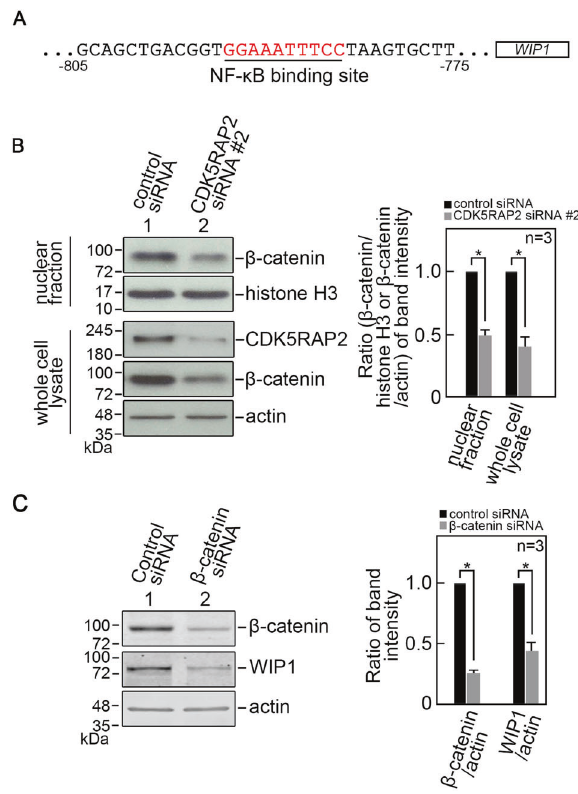
Fig. 5 CDK5RAP2 loss reduces β -catenin level. A The WIP1 promoter contains an NF- κ B binding site [32]. BJ cells transfected with CDK5RAP2 siRNA #2 ( B ), or β -catenin siRNA ( C ) for 3 days were analyzed by SDS-PAGE and immunoblotting. Nuclear fractions and whole-cell lysates in ( B ) were probed for β -catenin and histone H3 (nuclear fraction) or CDK5RAP2 and actin (whole cell lysate), and whole cell lysates in ( C ) were probed for β -catenin, WIP1, and actin. Actin blot was used as a loading control. Representative blots are from one of three independent experiments ( n = 3) showing similar results. Ratios of levels of β -catenin vs histone H3 (in nuclear fraction) or actin (in whole cell lysate) in ( B ) and β -catenin or WIP1 vs actin in ( C ), right panels, and standard deviation for the 3 independent sets of experiments were calculated as described for CDK5RAP2 vs actin in Fig. 1, with values from cells transfected with control siRNA normalized to 1.0. * p < 0.05 (in B ). * p < 0.005 (in C